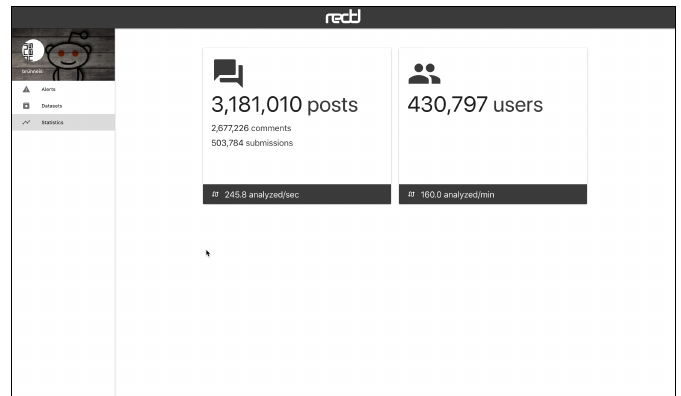
Figure 8. Statistics